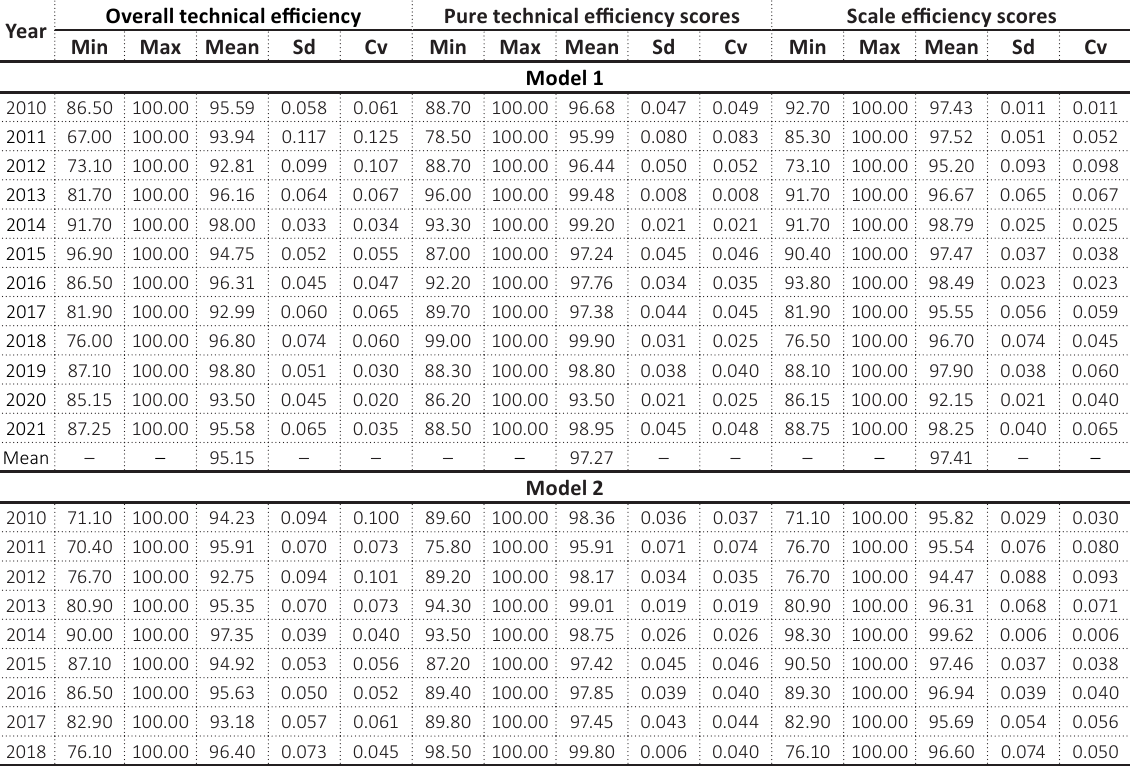
Table 3. Descriptive statistics of annual efficiency score of